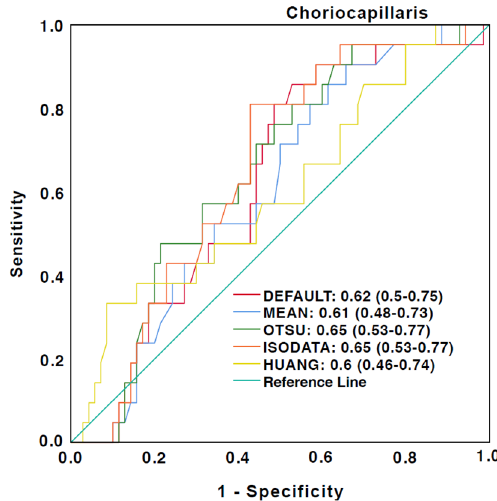
Figure 4. Receiver operating characteristics (ROC) curves for discrimination of diseased eyes from the healthy control group in the full retina slabs. The caption shows the area under the curve (AUC) values and the 95% confidence interval.